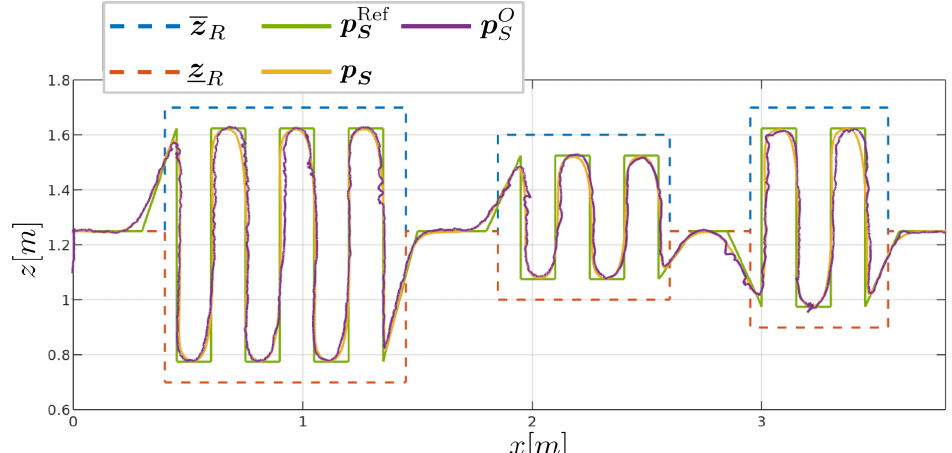
Figure 16. Comparison between the position of the spray frame obtained by the encoder measure- ments and the position obtained externally via the Optitrack camera system, denoted as p respectively. p Ref represents the reference lawnmower trajectory, and z R and z R represent the upper S and lower foliage boundaries,